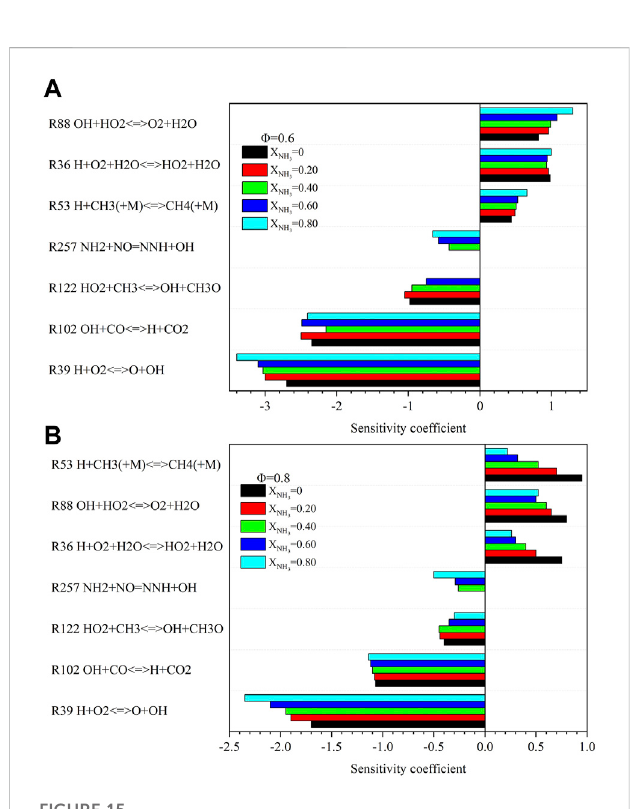
FIGURE 15 Sensitivity analysis of CO with different ammonia content: (A) Φ = .6; (B) Φ = .8. (T = 723 K, p = 16.5